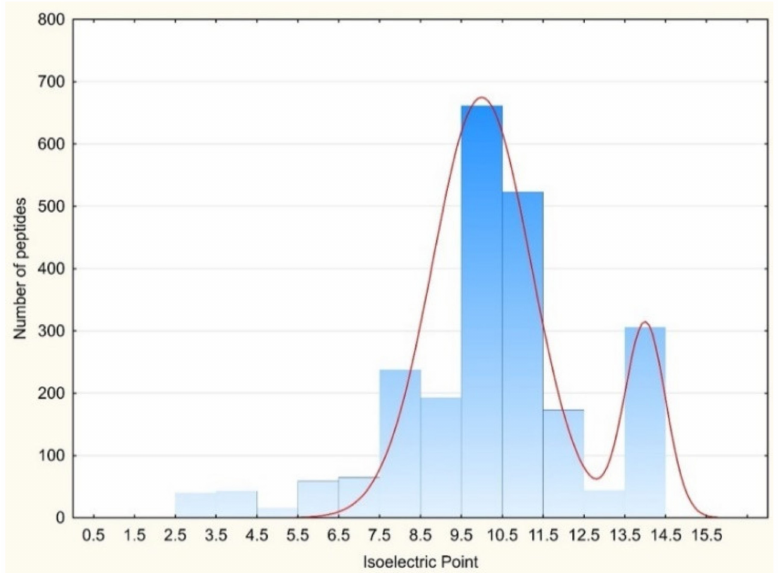
Figure 10. Distribution of the Isoelectric Point of ribosomal AMPs using the tools of the page of “Statistics” (https://dbaasp.org/statistics, accessed on 20 March 2021) of the DBAASP [17]. The fitting has done by the sum of two Gaussian curve